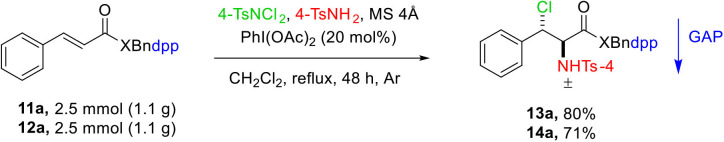
Gram scale reaction.